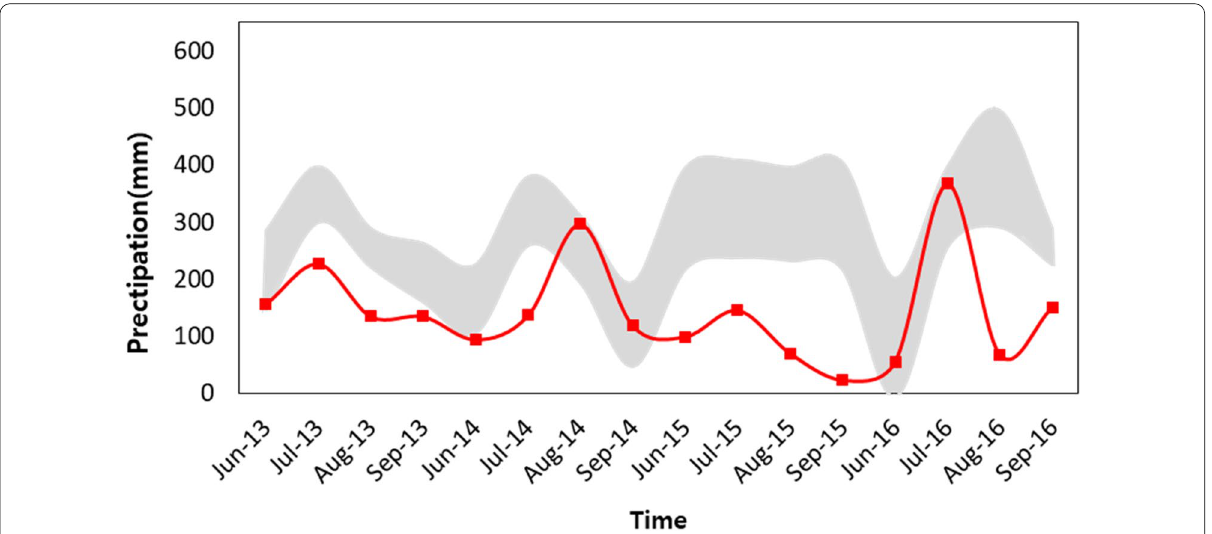
Fig. 8 Results of the precipitation prediction model based on teleconnection